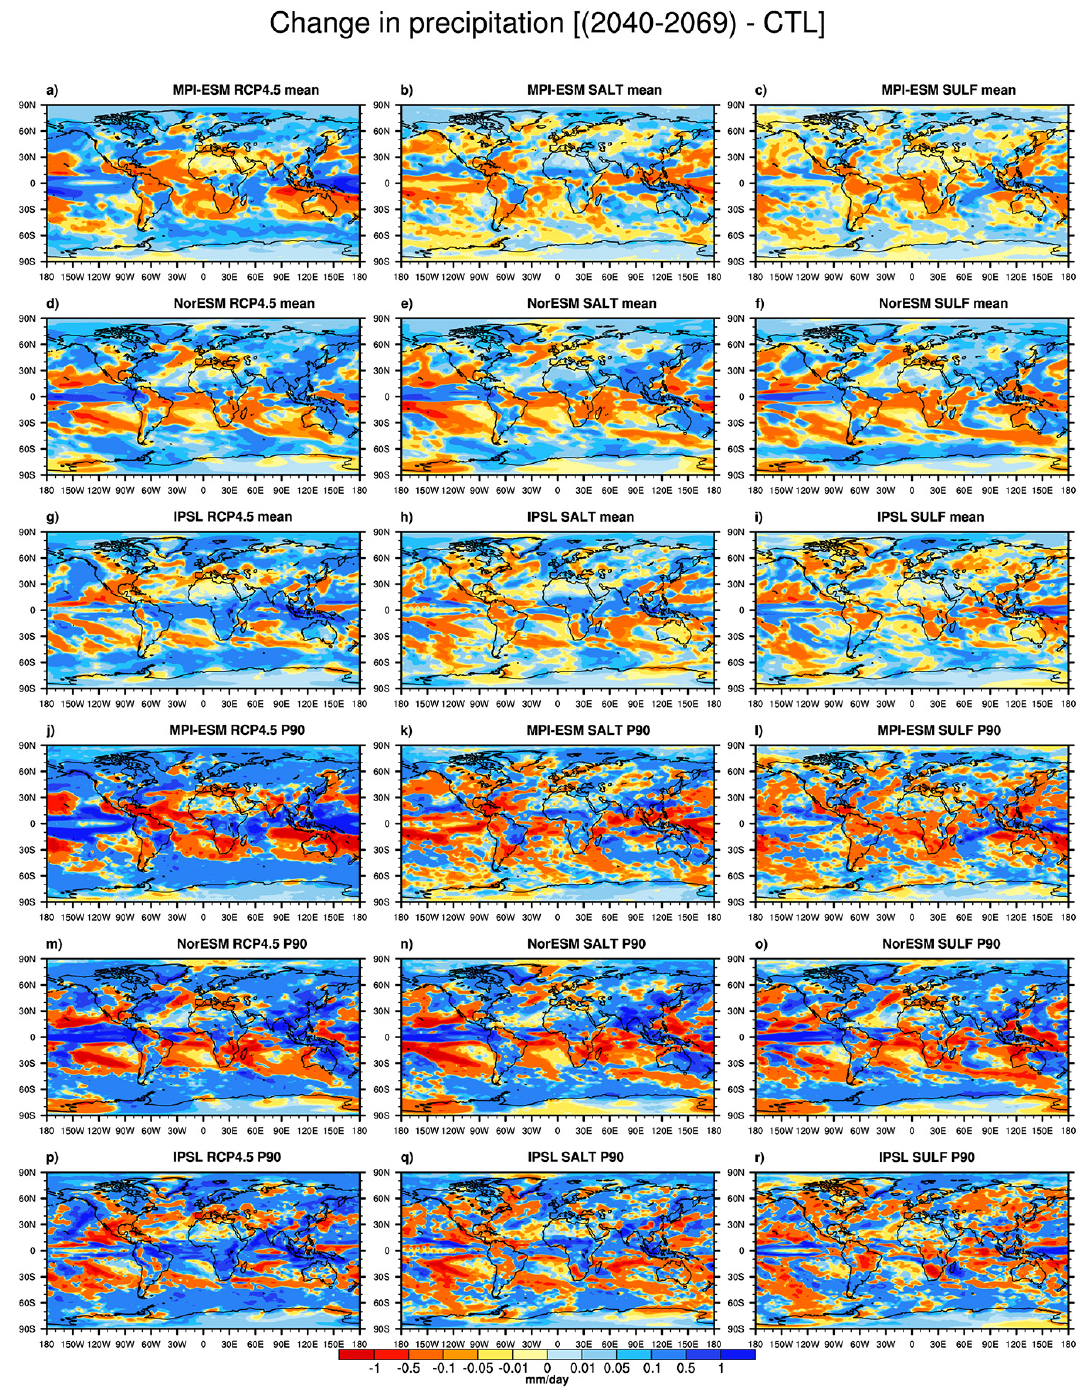
Figure 3. Change in precipitation (mmday − 1 ) for three scenarios RCP4.5, SALT and SULF and three models MPI-ESM, NorESM, IPSL for mean (first three rows) and P90 (last three rows) for the 2040–2069 period minus the RCP4.5 2006–2035 control period